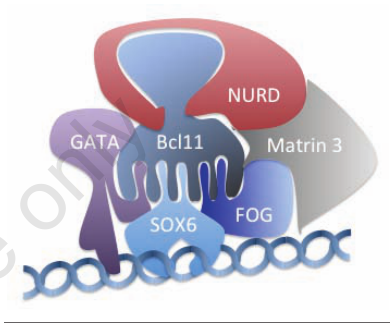
Figure 4. Schematic representation of the most important partners that interact with